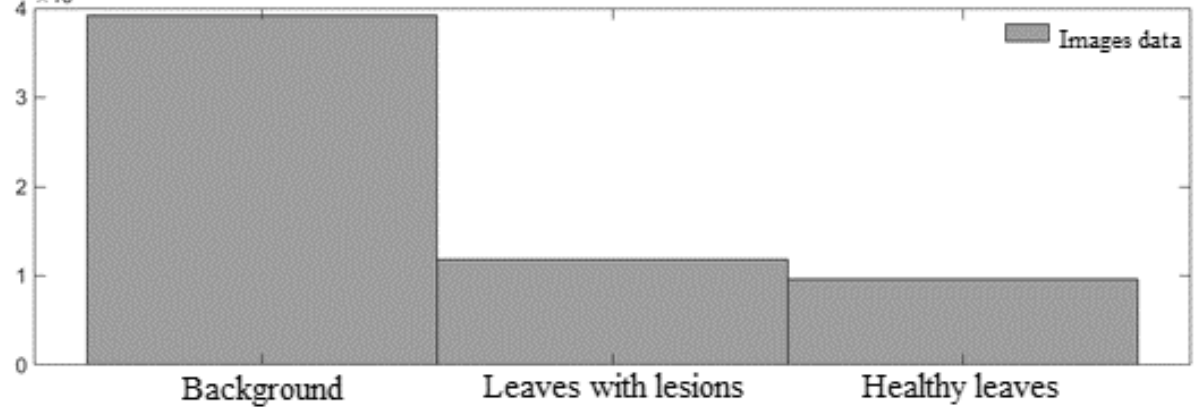
Figure 4. Distribution of the frequency in the original data labeled manually in the data bank of the training and testing data.